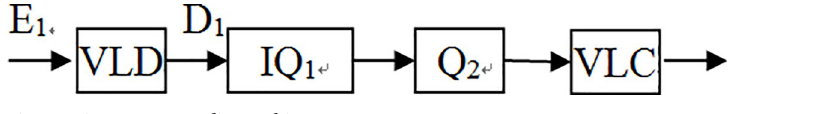
Fig 6. I-pictures transcoding